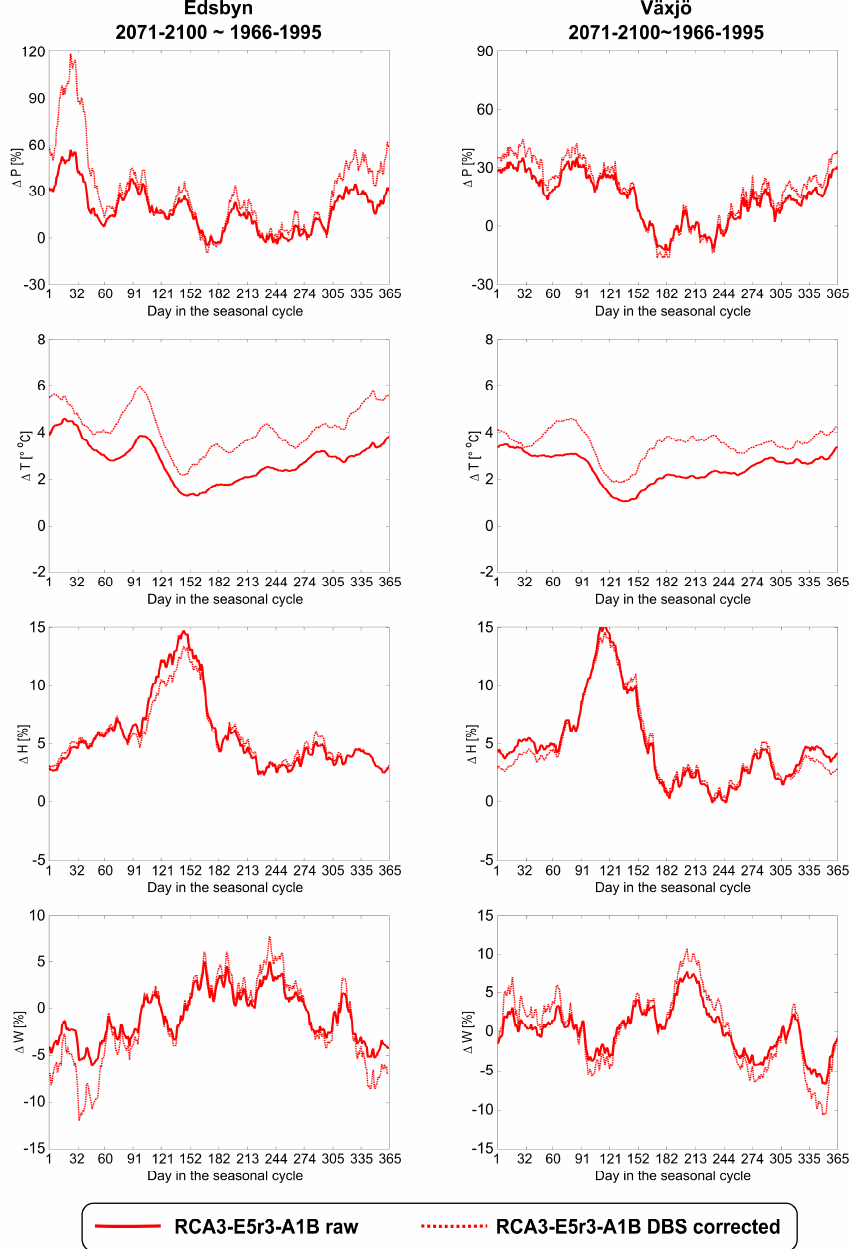
Figure 9. Climate change signals in P (precipitation), T (temperature), RH (relative humidity) and W (wind speed) at Edsbyn and Växjö station (see Fig. 1), reflected in RCA3-E5r3-A1B before and after correction during